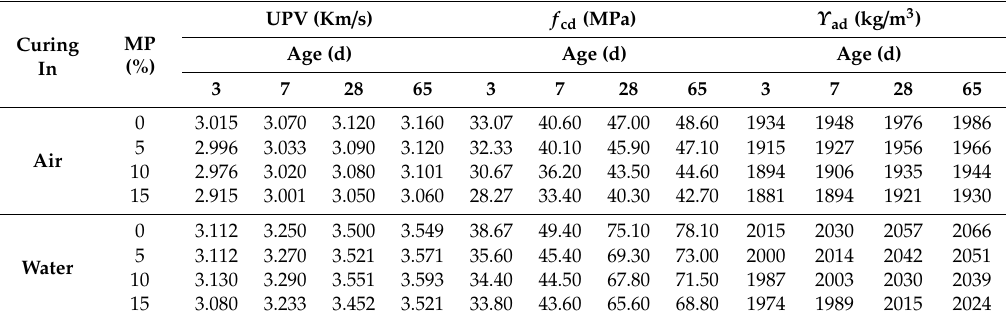
Table 2. Mean value of compressive strength, ultrasonic pulse velocity (UPV), and apparent density of cement paste containing MP.